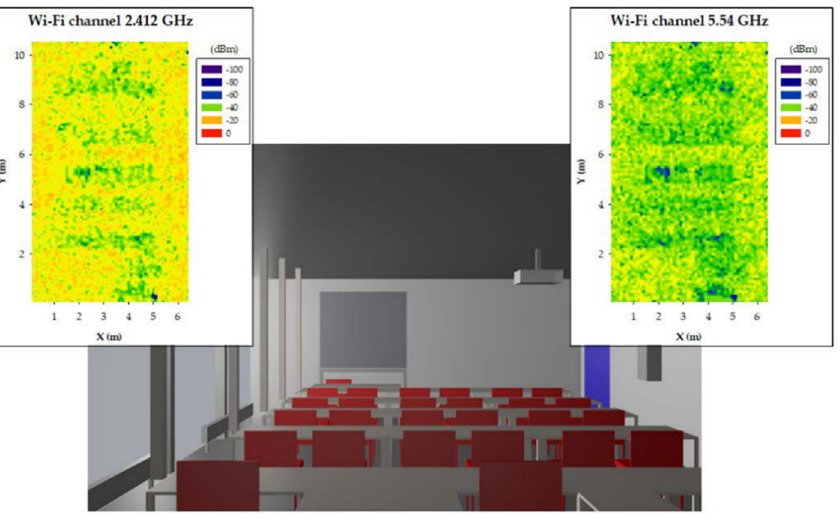
Figure 12. Three-dimensional model of the test classroom and the received signal power for HoloLens 2 glasses that used 2.4 GHz and 5 GHz Wi-Fi [71].